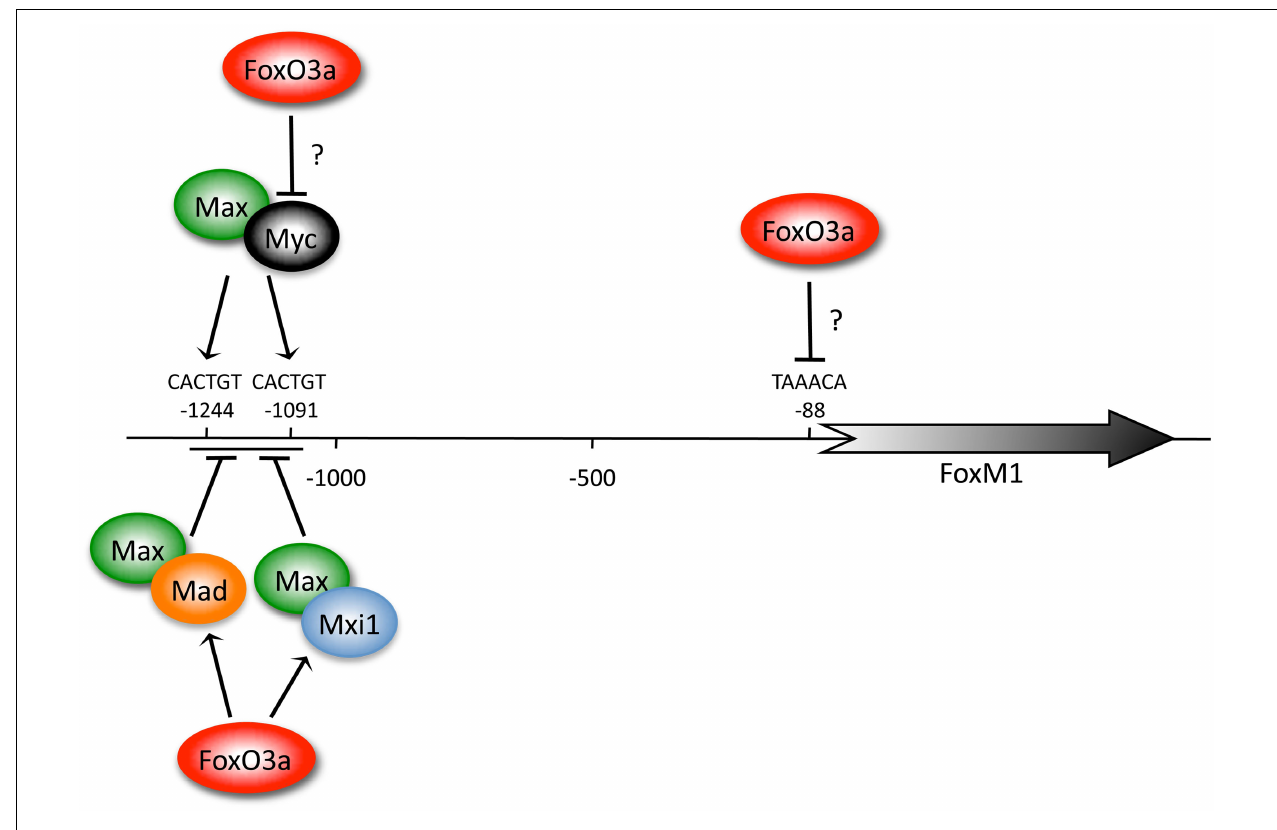
and Mxi1/Max dimers bind the same E-boxes, but repress expression. Thus, increased expression of Mxi1 and Mad by FoxO3a could inhibit FoxM1 expression by blocking Myc/Max dimerization.Third, Myc protein levels decrease when FoxO3a expression is increased, perhaps through a post-translational mechanism, providing another method to potentially repress FoxM1 expression following FoxO3a activation.This figure is based on work from Delpuech et al. (2007) and Fernandez et al.